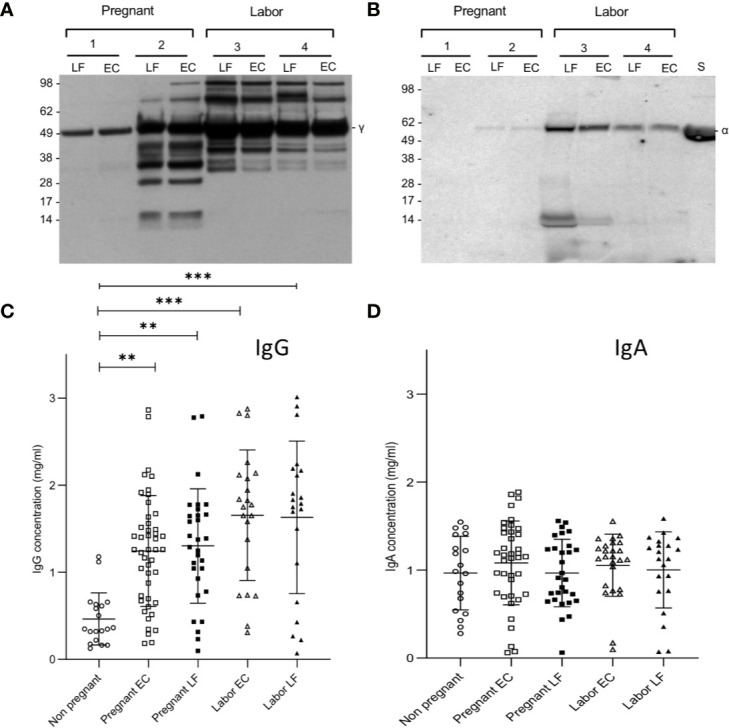
Immunoblotting analysis of IgG and IgA heavy chains and levels of IgG and IgA in EC and LF during pregnancy and labor. Samples 1 and 2 were from pregnant women and samples 3 and 4 from women in labor. As shown in (A), IgG is abundant in all samples. More quantitative variation exists for IgA (B). In the selected samples from pregnant women patient number 1 was found to be IgA-deficient. Antibodies used were specific for the γ (IgG) and α (IgA) heavy chains, both approximately 50 kDa in size. Quantification of IgG (C) and IgA (D) was done by ELISA. Higher concentrations of IgG were found in the EC and LF during pregnancy and labor in comparison to IgA. IgG concentration is significantly higher during pregnancy and during labor both in the EC and the LF in comparison to the nonpregnant controls (**P < 0.01, ***P < 0.001; one-way ANOVA and Tukey´s multiple comparison test).